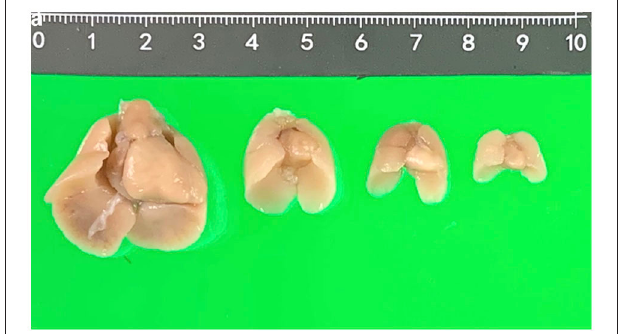
FIGURE 1 | Fetal hearts and lungs in different gestational weeks (17, 15, 13, and 12 weeks, respectively).